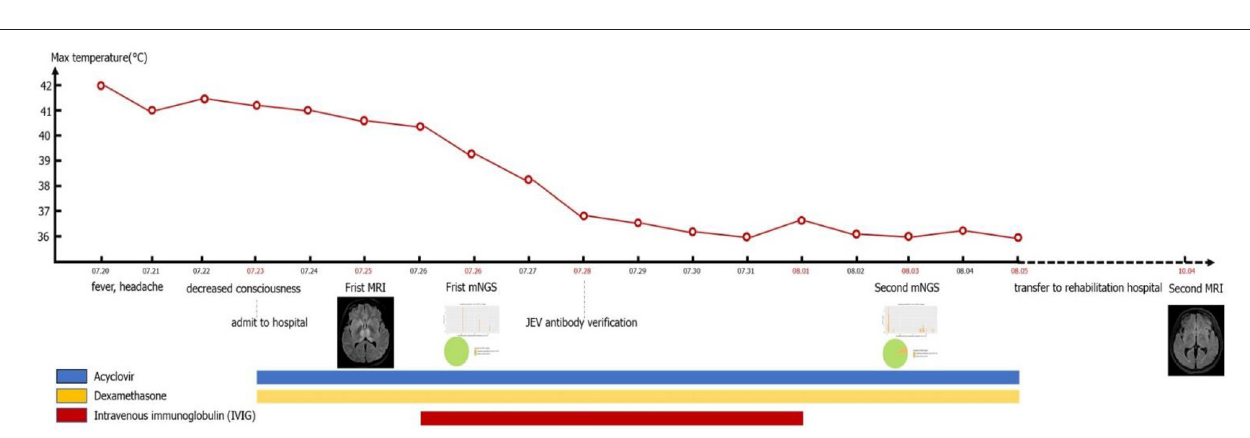
FIGURE 4 | Timeline of the patient’s clinical symptoms, temperature change process, drug use, mNGS, and